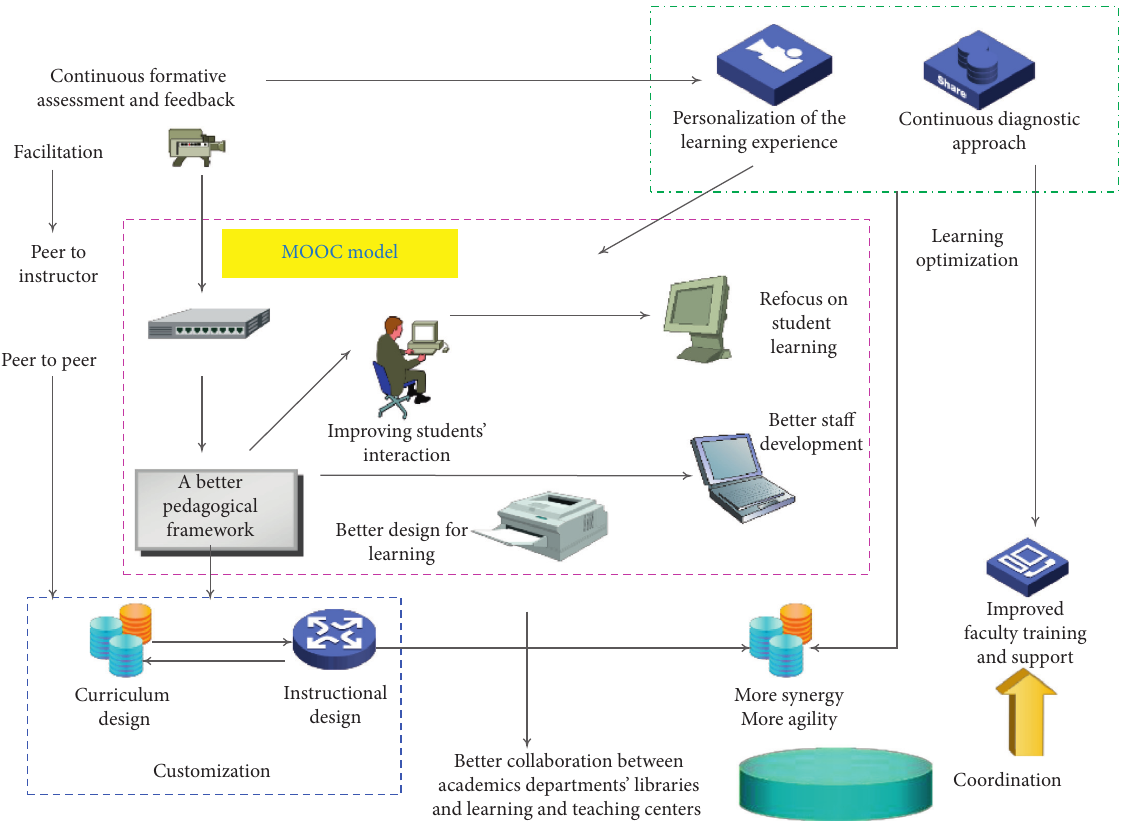
Figure 1: The relationship among the elements of the MOOC teaching